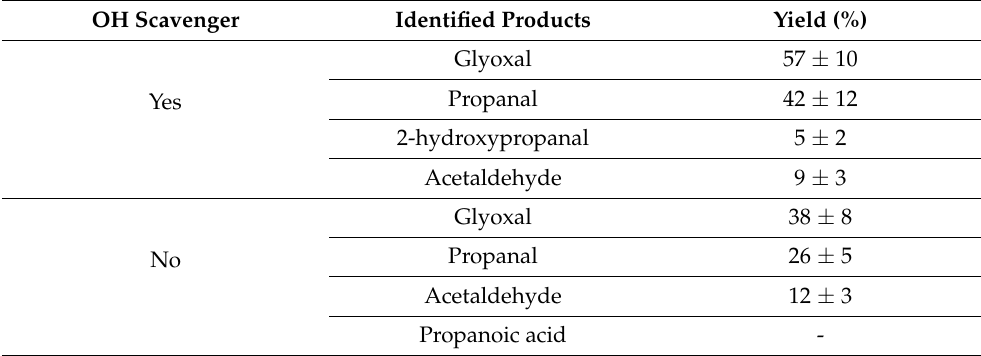
Table 2. Product formation yields obtained during the ozonolysis of T2P in the presence and the absence of cyclohexane. Uncertainties represent 2 σ